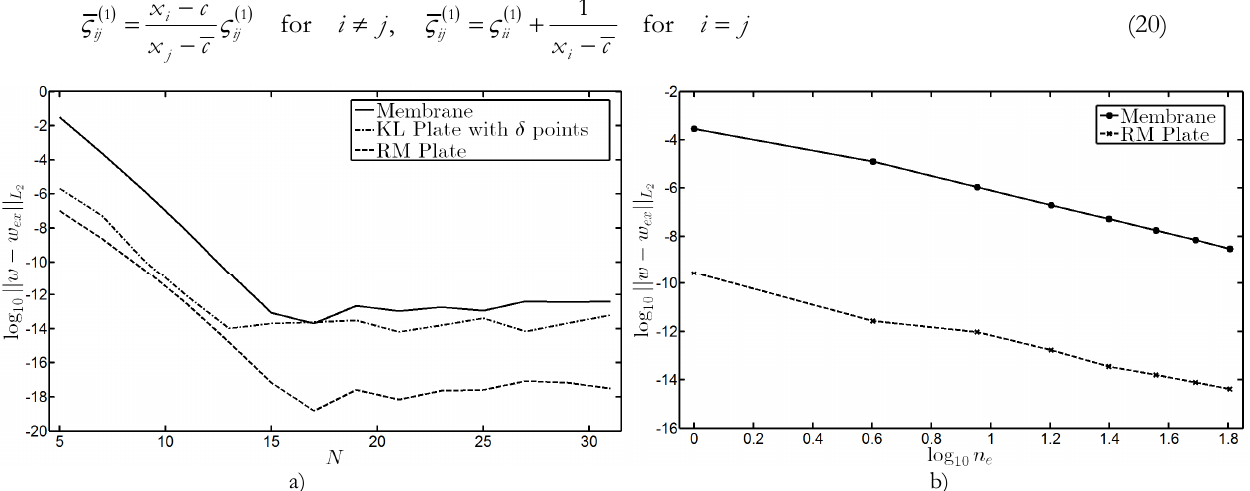
Figure 6: a) Static analysis for single element structural components varying the number of points N for a Membrane, a KL plate with  -points ( 5 10  ) and a RM plate using PDQ basis functions and Che-Gau-Lob grid distribution. b) Static analysis for structural n with 7 N  for a Membrane and a RM plate using PDQ basis functions and Leg- components varying the number of elements e Gau grid distribution.